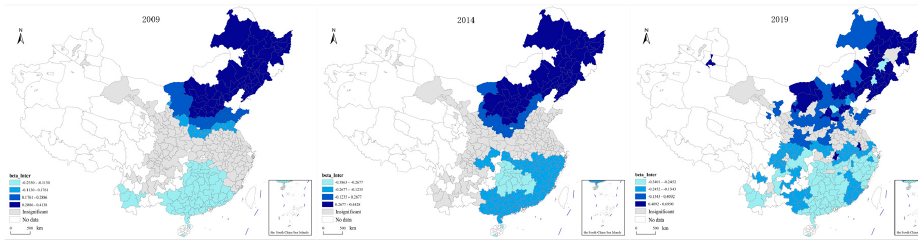
Figure 4. Spatial distribution of constant